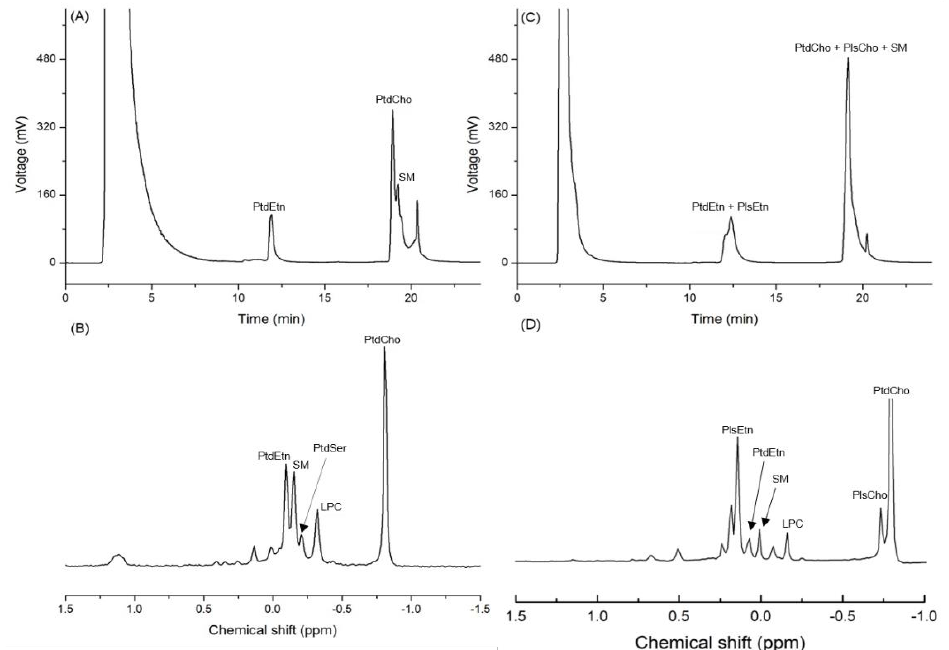
Figure 2. Chromatogram of phospholipids from infant formula (IF) and dried big head shrimp an-